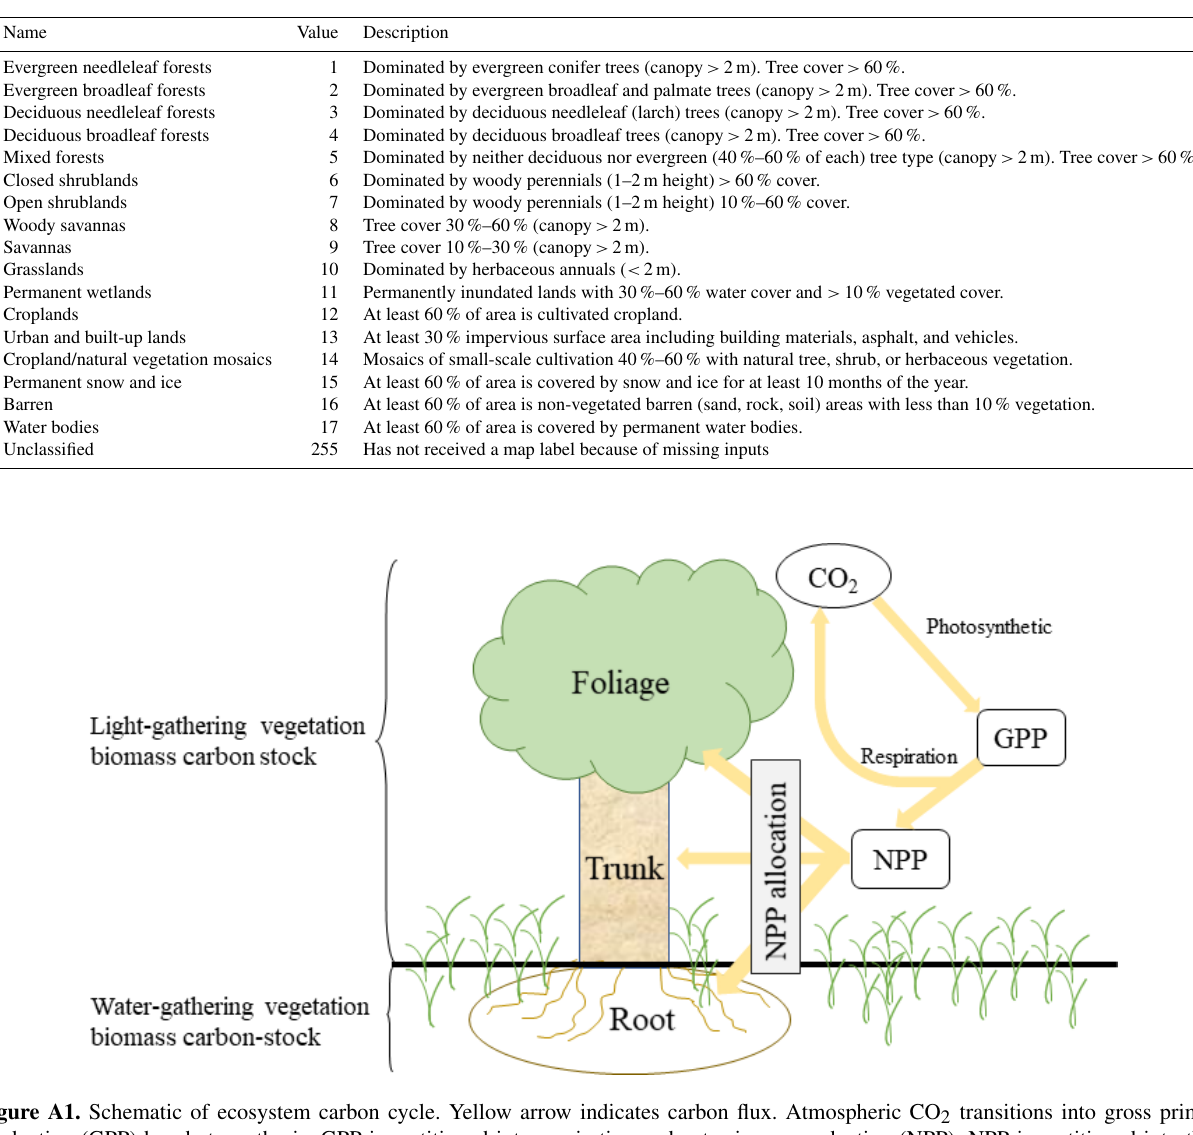
Table A1. MCD12C1 legend and class descriptions.